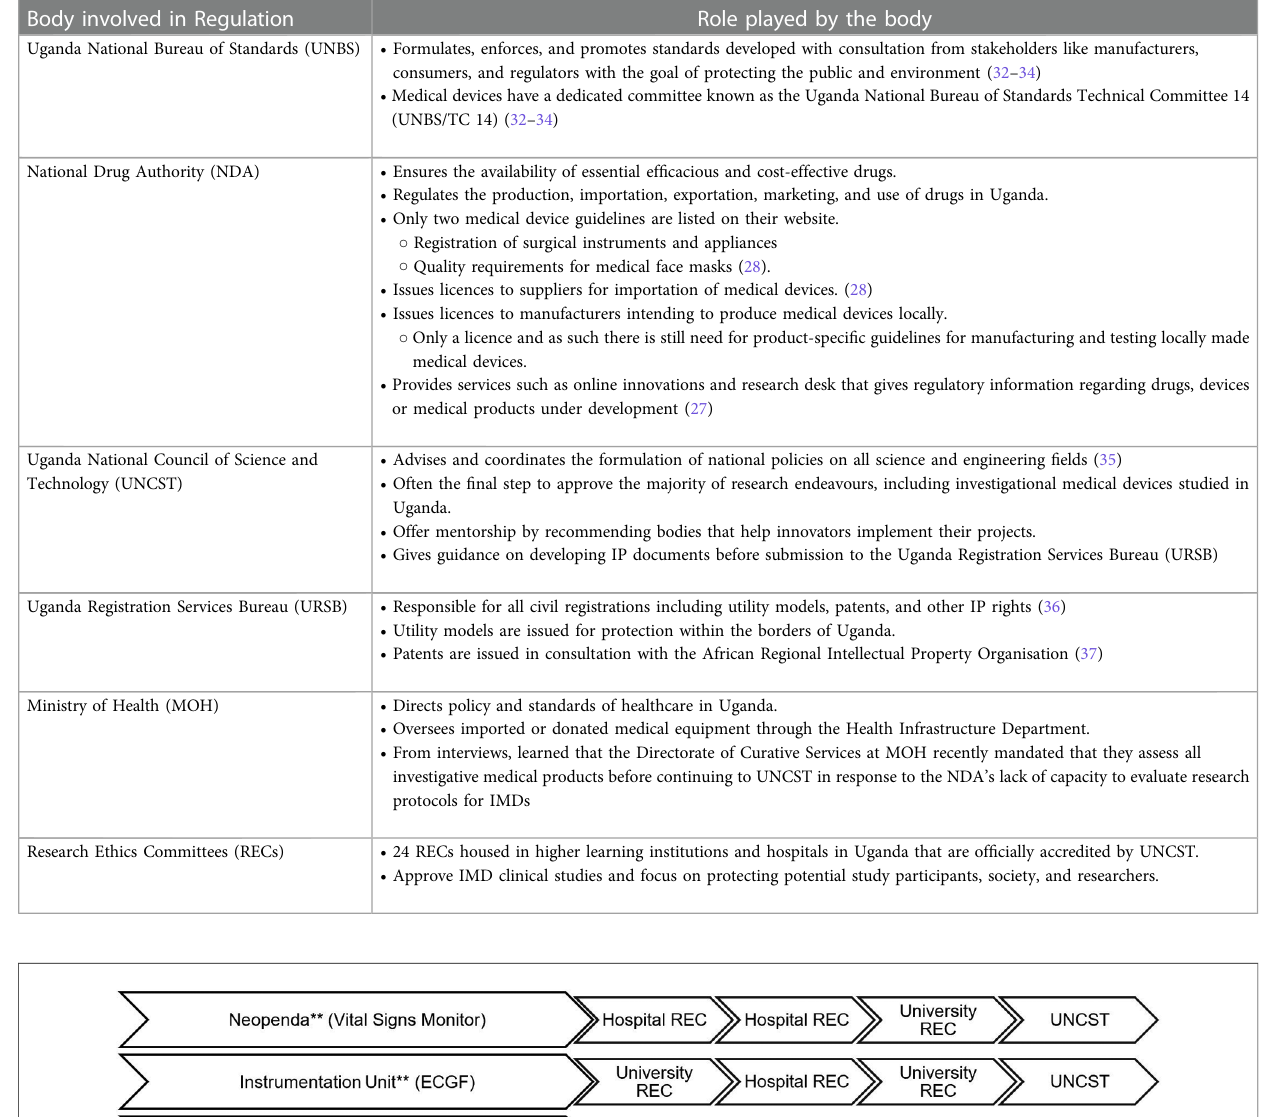
TABLE 2 Descriptions of bodies involved in regulation in Uganda.